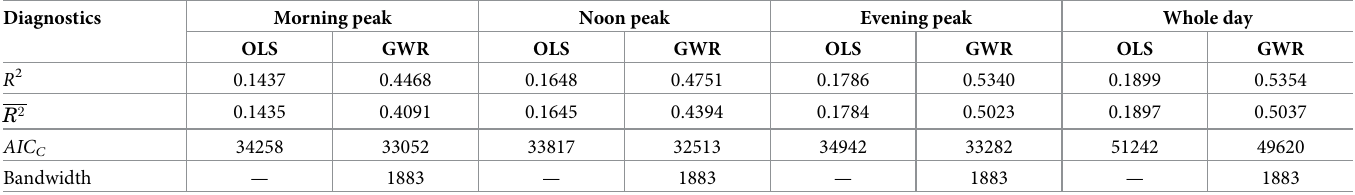
Table 5. Comparison results of the OLS and the GWR model on